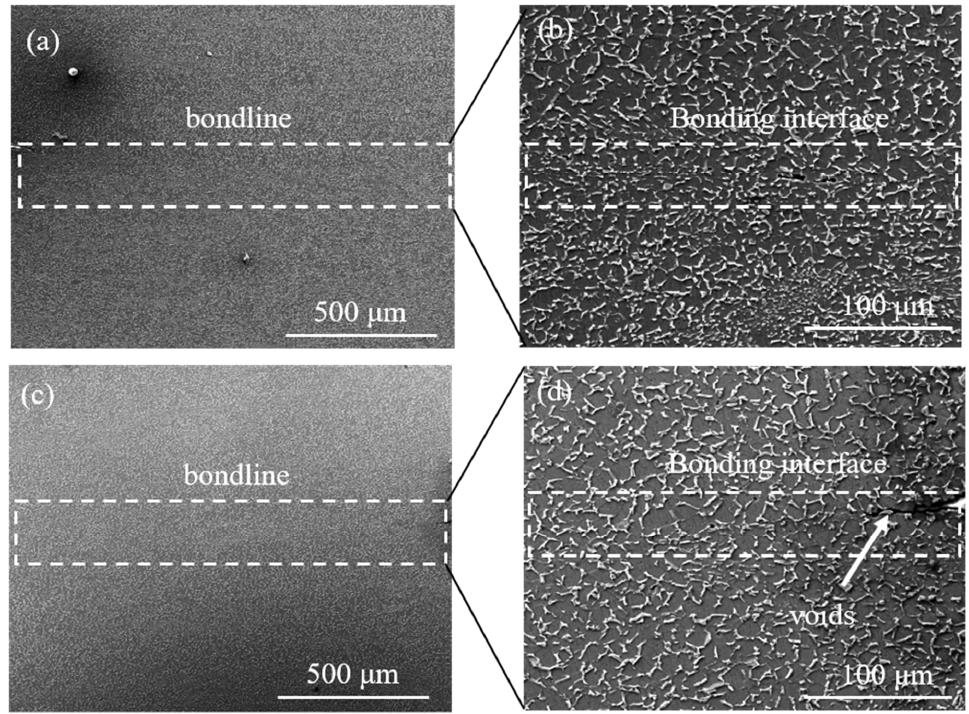
Figure 5. ( a , b ) SEM images of the bond interface for initial SP700 alloy; ( c , d ) Microstructure of the heat-treated alloy after diffusion bonding.